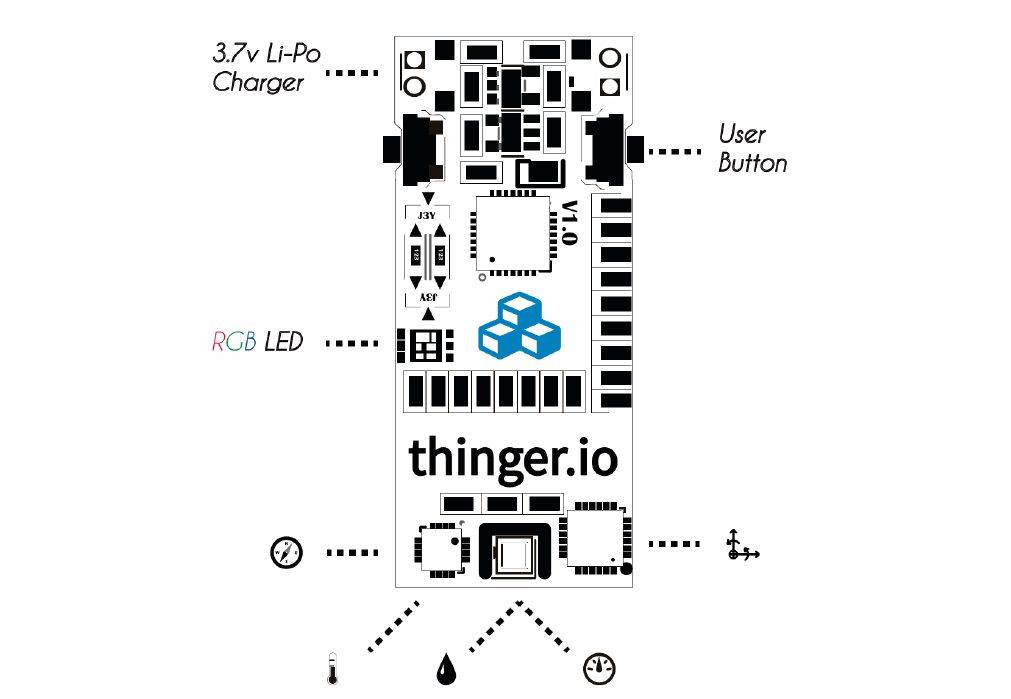
Figure 17. Thinger.io physical interface.